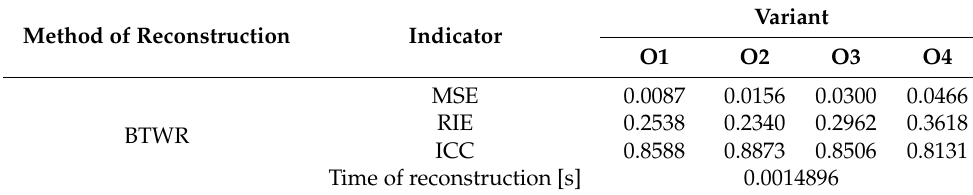
Table 1. Image reconstruction indicators—BWTR